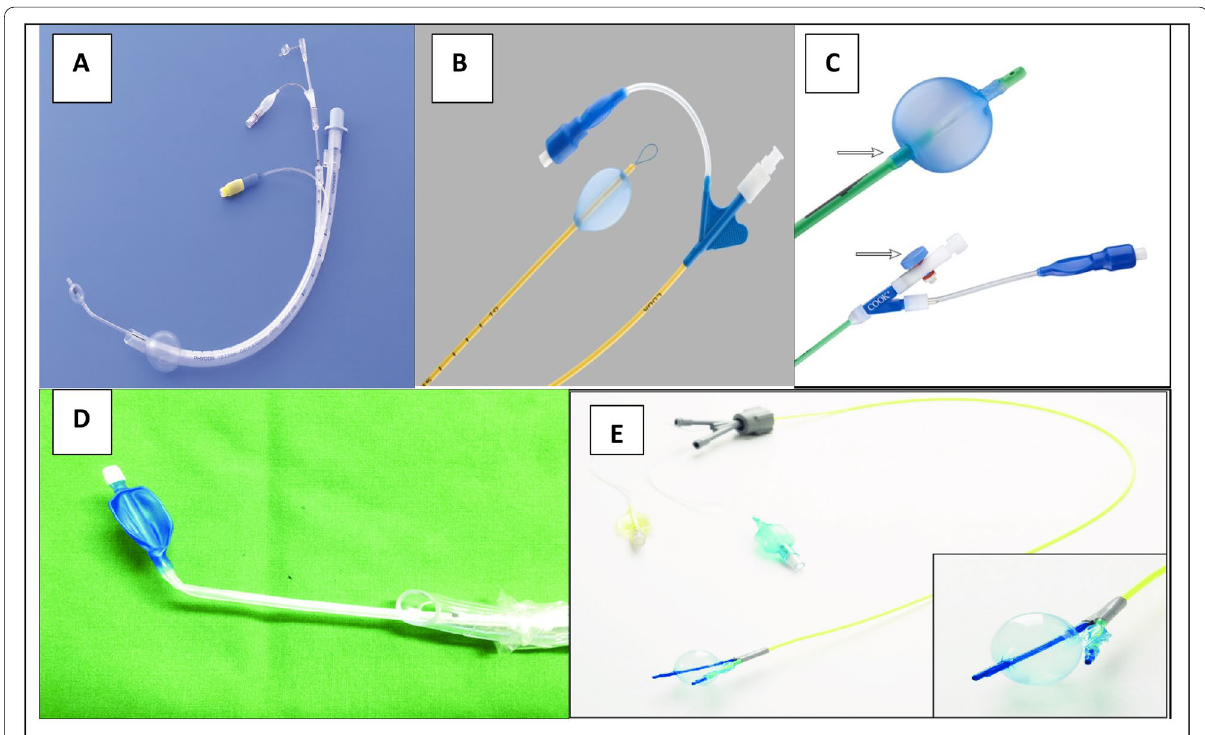
Fig. 2 A Torque control blocker uninvent. B Arndt bronchial blocker with looped guide wire C Cohen flexitip bronchial blocker D Coopdech bronchial blocker with preformed angulation at distal tip E Y-shaped EZ